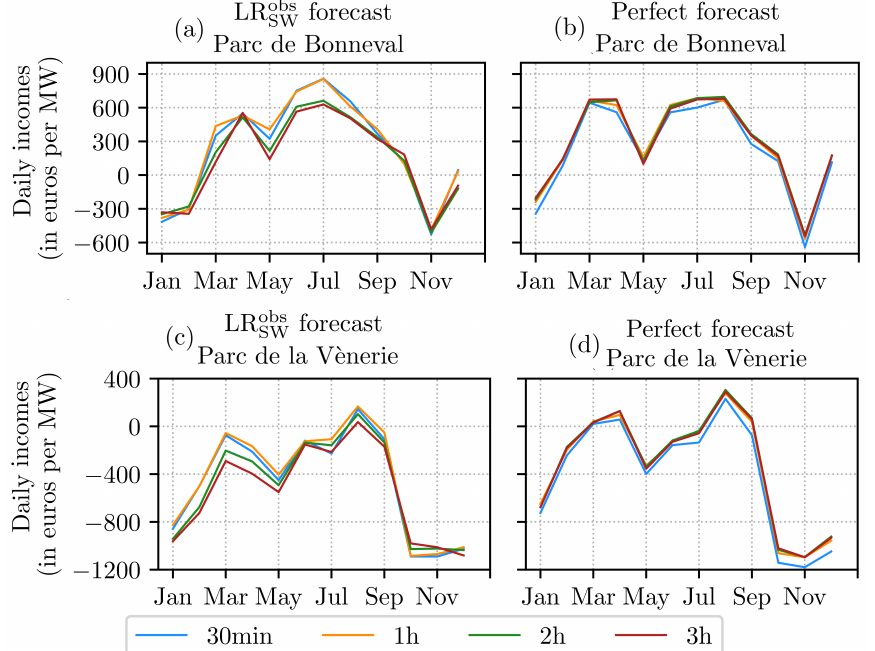
Figure 8. Daily income from intraday market averaged over months at Parc de Bonneval (( a ) and ( b )) and at Parc de la Vènerie (( c ) and ( d )) in 2015. For both farms, four different balancing times (30 min, 1 h, 2 h, and 3 h before the delivery date) are shown. Panel ( a ) (resp. ( c )) displays the results when the nowcast is provided by LR obs at Parc de Bonneval (resp. Parc de la Vènerie), and panel ( b ) (resp. ( d )) SW assumes perfect knowledge of the realized production at Parc de Bonneval (resp. Parc de la